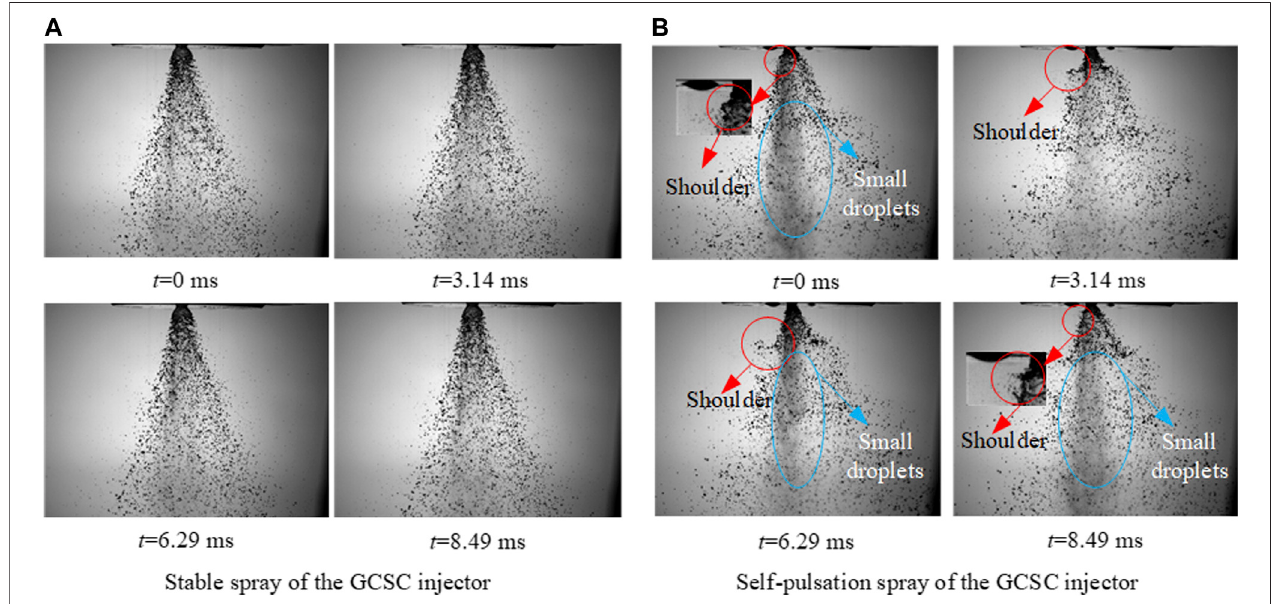
FIGURE 4 | Spray images of the GCSC injector: (A) Stable spray of the GCSC injector; (B) Self-pulsation spray of the GCSC injector.